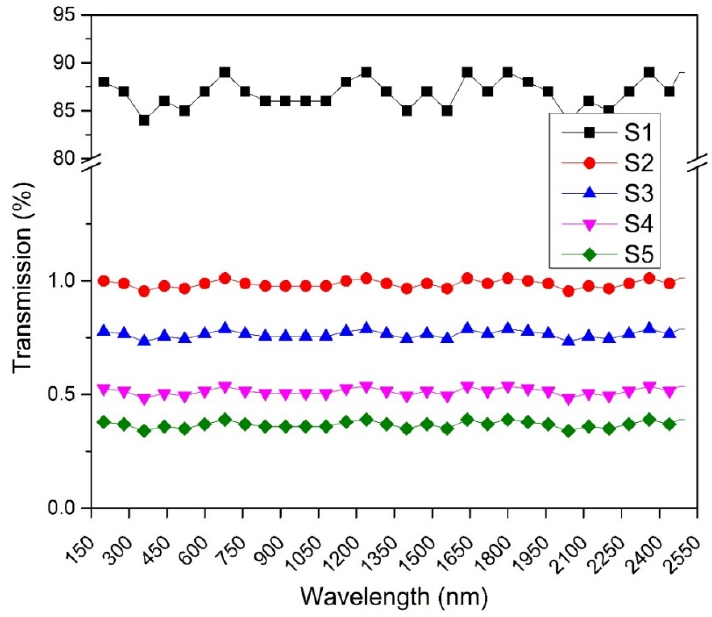
Figure 7. UV/Vis/NIR transmissions.